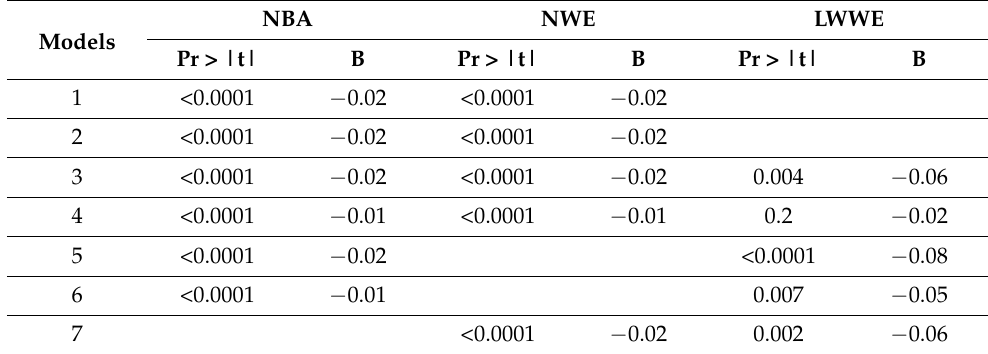
Table 8. Estimated trends for